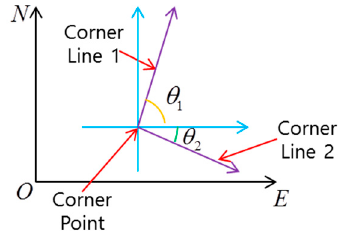
Figure 2. Attribute of the corner feature.